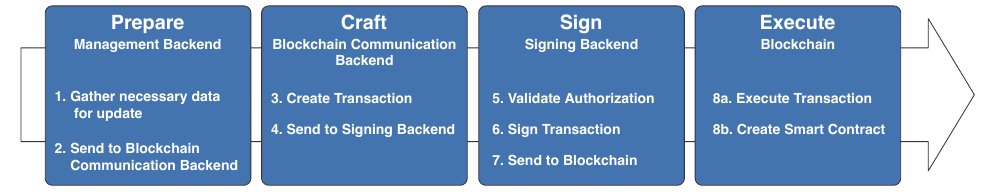
Figure 7. General process for creating and signing